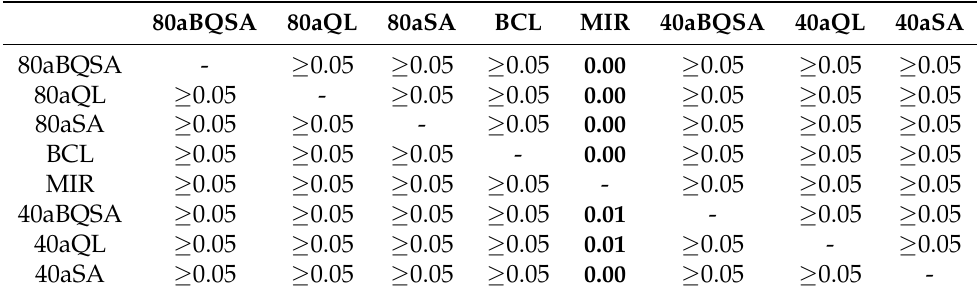
Table 8. Average p -value of WOA compared to others